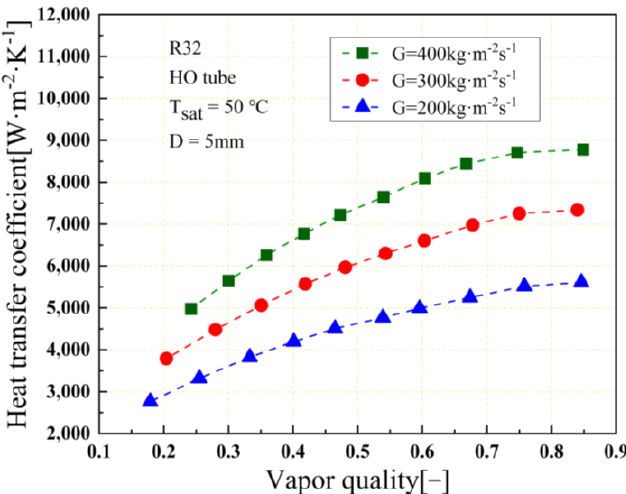
Figure 13. Predicted average heat transfer coefficient over HO tube with varied vapor qualities.